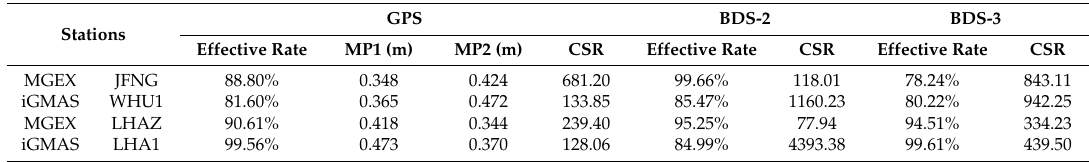
Table 1. Comparison of data quality between iGMAS and MGEX